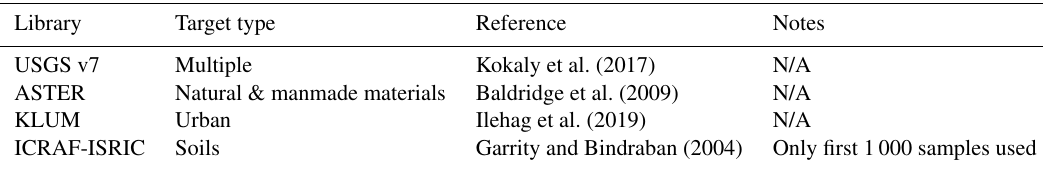
Table D1. List of spectral libraries used to define spectral